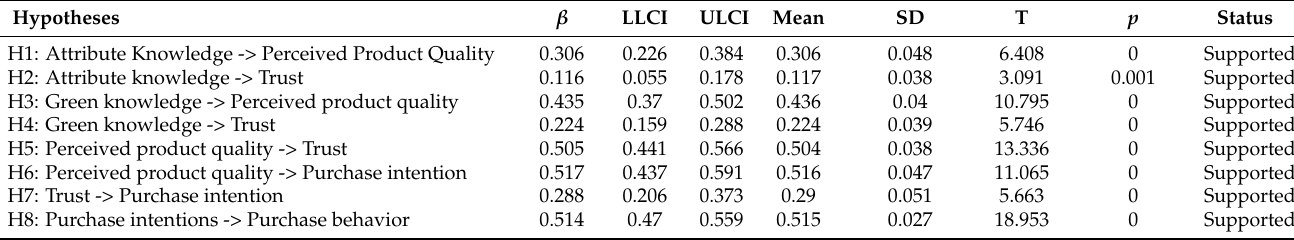
Table 9. Hypothesis testing.